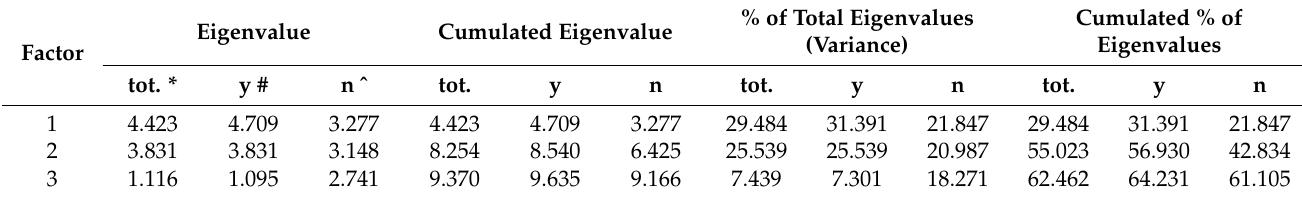
Table 2. Hierarchy of factors according to their eigenvalues established on the basis of the Kaiser criterion (depending on respondents’ opinions on whether the employer’s image created on the basis of modern marketing communication channels is more beneficial than the employer’s image created on the basis of classical marketing communication channels). % of Total Eigenvalues Cumulated % of Eigenvalue Cumulated Eigenvalue (Variance) Factor